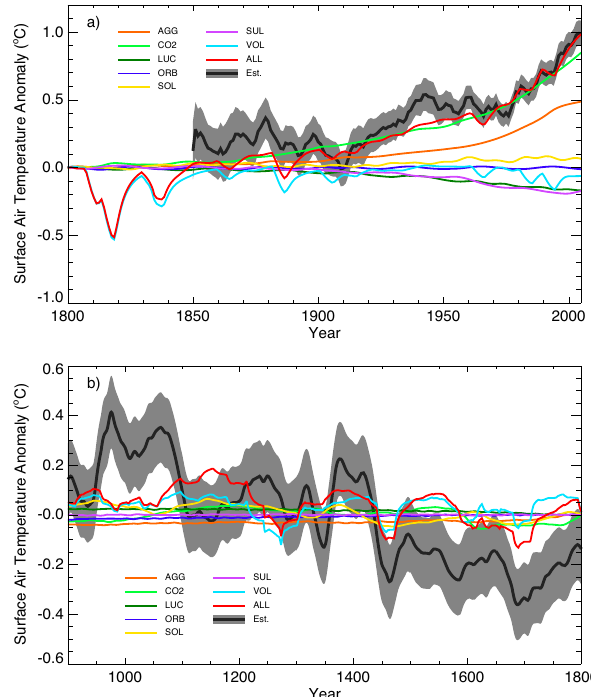
Fig. 8. Individual forcing component contributions to the total global surface air temperature response. The model results are from the average of 11 models: B3, C2, C3, DC, GE, I2, LO, MI, ME, UM and UV. The response after 1800 is shown in (a) . The dark grey line shows changes in global SAT, and the grey shading indicates the uncertainty, from Morice et al. (2012). The model results and the data estimates were processed with a 5yr moving average, rectan- gular filter. Model results are shown as anomalies from the decade centred at 1800. The data estimates are shown as an anomaly, which has been offset to show the same SAT anomaly as the all-forcing av- erage over the decade centred on the year 1900. The response before 1800 is shown in (b) . The dark grey line shows changes in global SAT, and the grey shading indicates the uncertainty, from the EIV reconstruction of Mann et al. (2008). Model results and data esti- mates are shown as anomalies from their average over the entire period (850 to 1850) and have been processed with a 30yr moving average, rectangular